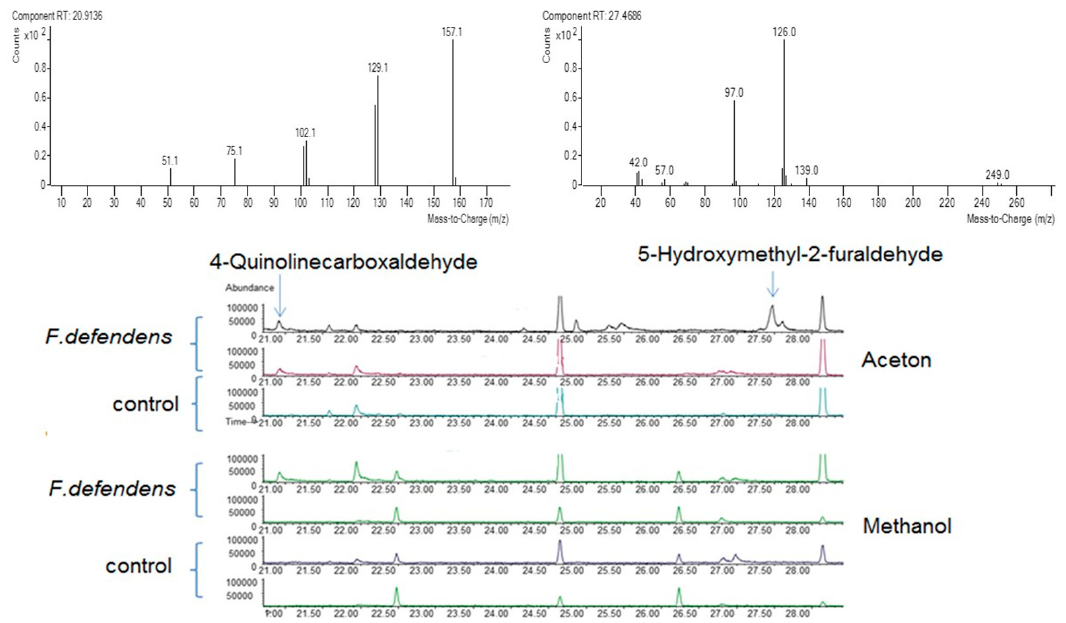
Figure 1. Identification of F. defendens -secreted metabolites by gas chromatography–mass spectrometry (GC-MS) analysis. The F. defendens culture supernatant was fractionated using di ff erent solvents. Fractions showing spiroplasma inhibition activity were analyzed by GC-MS. The lower section shows the gas chromatography spectrum of substances extracted by acetone and methanol (two-sequel fractions for each extract) from the filtrate of F. defendens or from the sterile control medium. Arrows indicate the dominant compounds found only in the fraction containing the bacteria. The upper section shows the mass spectra of these compounds: 4-quinolinecarboxaldehyde ( left ) and 5-hydroxymethyl-2-furaldehyde ( right ).